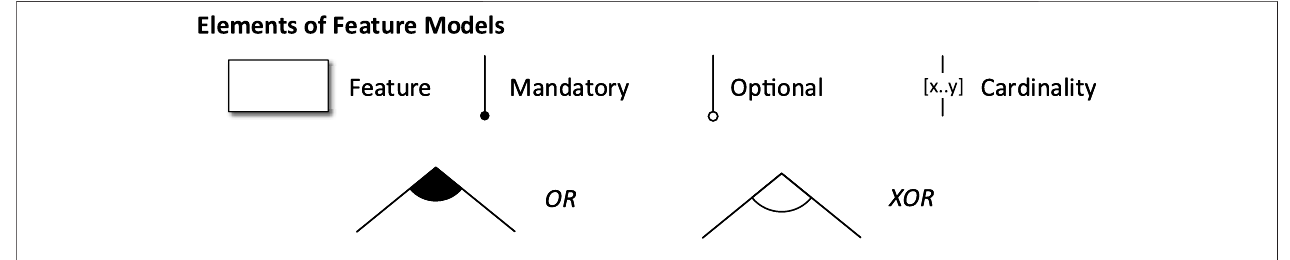
FIGURE 2 | Elements of our feature